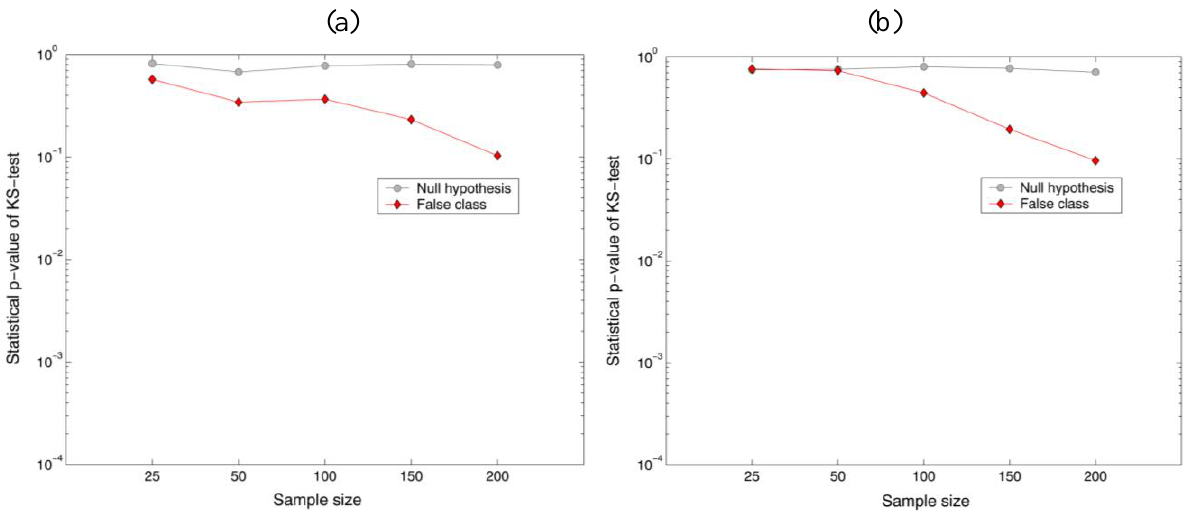
Figure 7. The average statistical p-value calculated from the nonparametric KS-test. (a) real part and (b) imaginary part in the reconstructed image. Reference: Oscillatoria bacteria. False class: Diatom